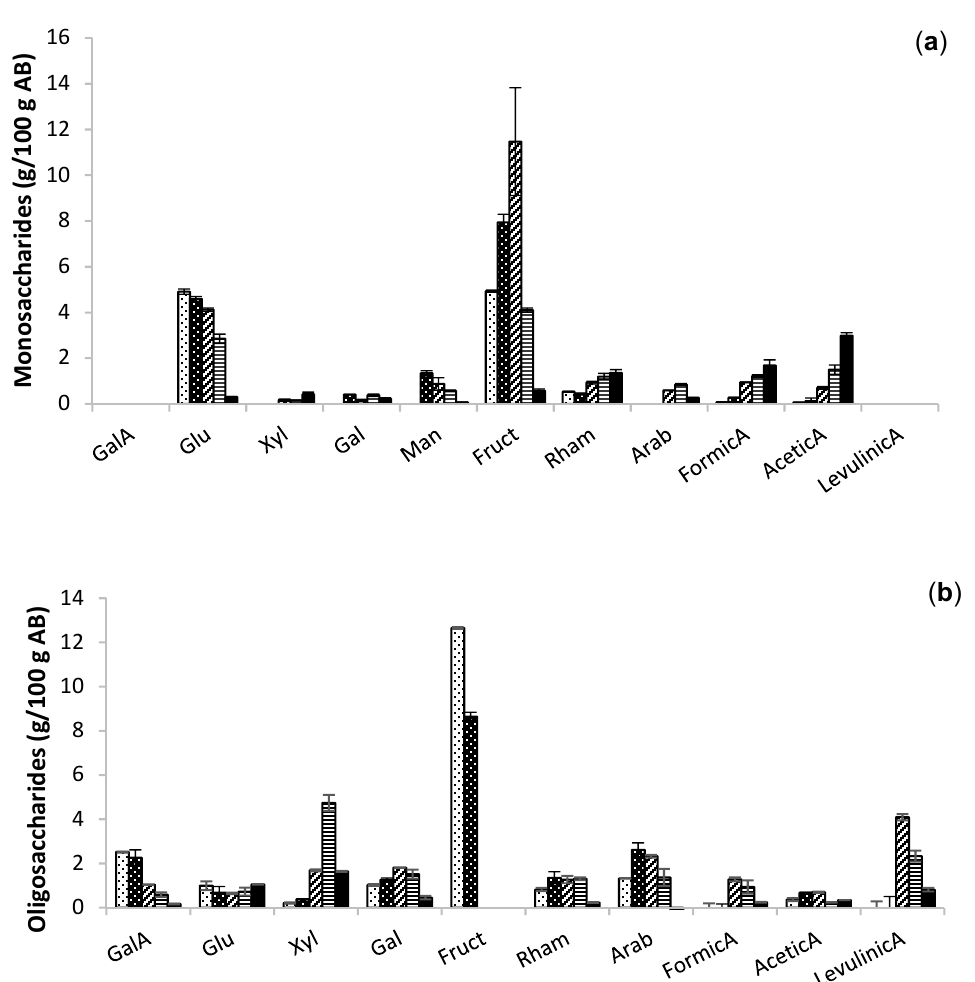
Figure 4. Extraction of ( a ) monosaccharidic and ( b ) oligosaccharidic fractions of extracts obtained at different temperatures; 140 (black dots), 160 (white dots), 180 (slanted lines), 200 (horizontal lines), and 220 °C (filled bars) of microwave assisted heating.